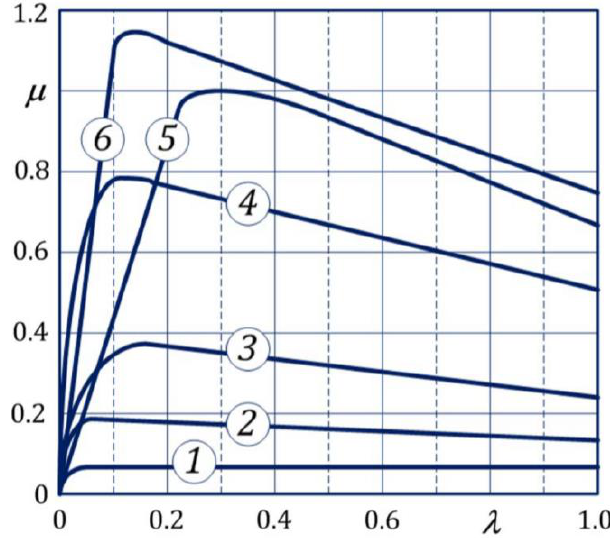
Figure 2. Generic tire friction-slip curves. 1–glaze ice; 2–snow; 3–wet cobbled roadway; 4–wet worn-out asphalt; 5–dry cobbled roadway; 6–dry asphalt. [4].